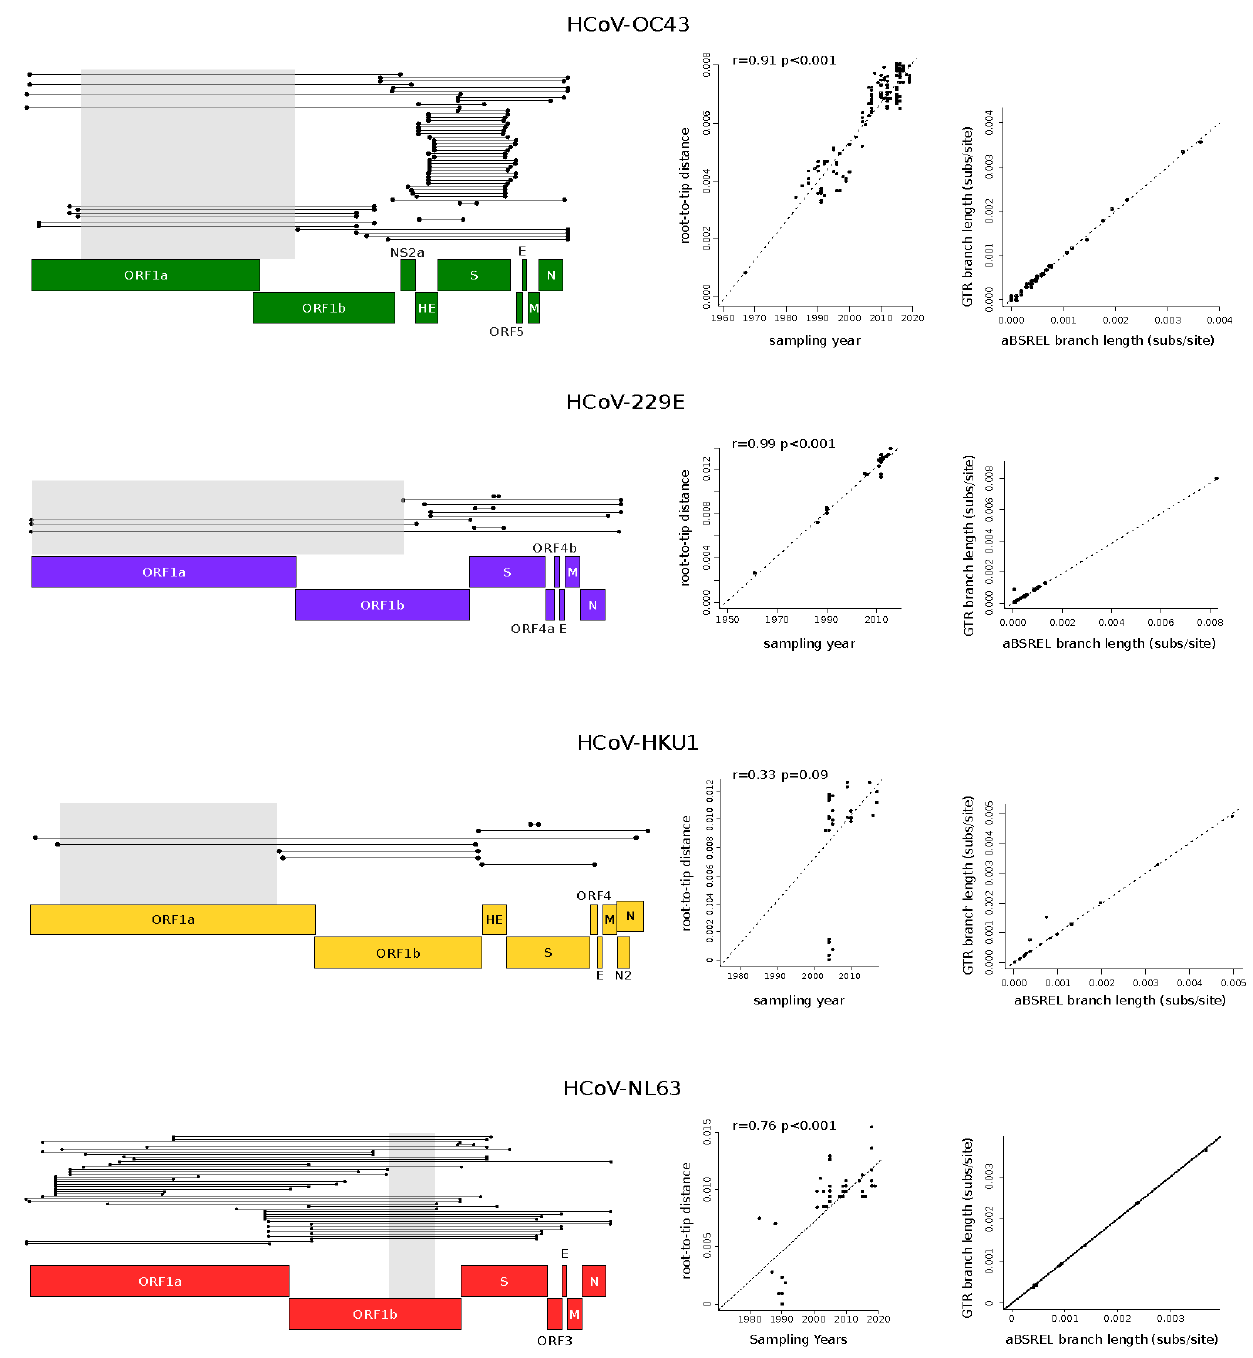
Figure 1. Recombination events and temporal signal. Unique recombination events in endemic coronaviruses ( left panels ). Each event is shown as a line with dots representing the start and the end. The non-recombinant regions used in the analyses are indicated with gray shadows. Schematic representations of coronavirus genomes are also reported. Plots of the root-to-tip distance as a function of sampling years are shown in the central panels. Each point corresponds to a viral sequence and the dotted line is the linear regression calculated using a method that minimizes the residual mean squares. The r coefficient and the corresponding p value are also shown. ( right panels) report comparisons of branch lengths obtained using the aBSREL and the GTR models. Each dot represents an internal branch of a phylogenetic tree calculated using the longest non-recombinant regions of each endemic coronavirus.